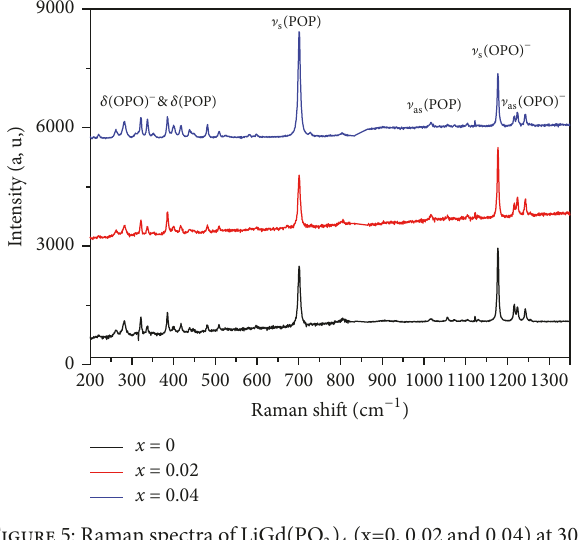
Eu (PO 3 ) 4 (x=0, 0.02 and 0.04). x - x )